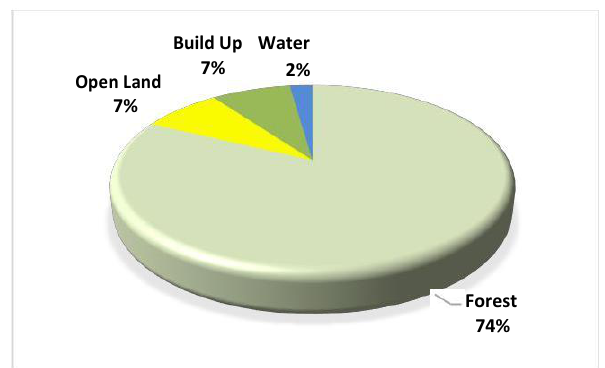
Graph 2: Supervised Classification Area Percentage (%) Margalla Hills Year